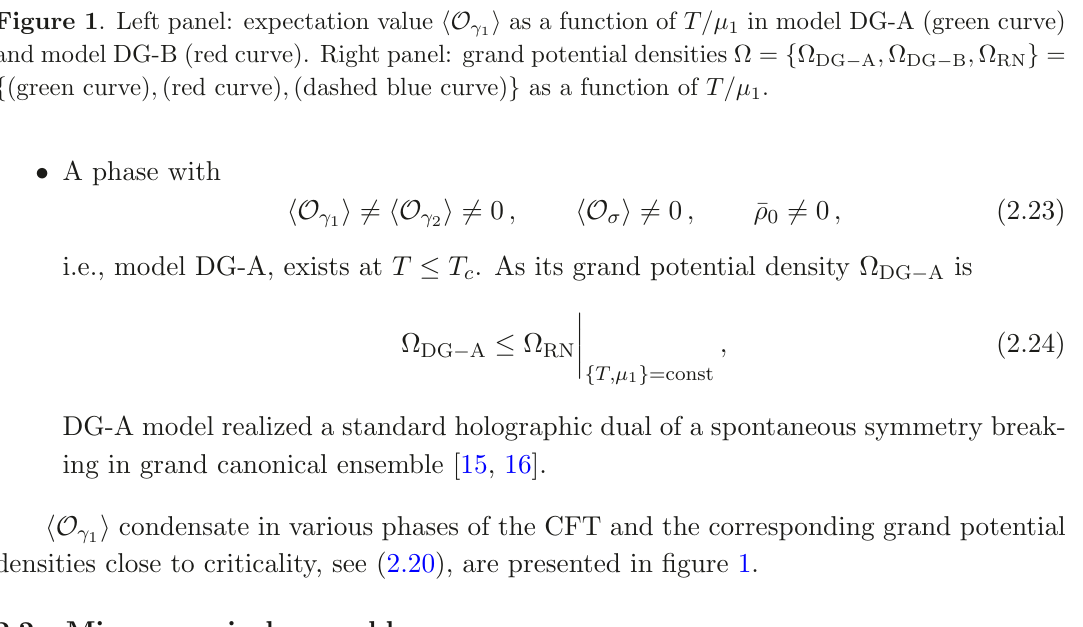
Ω DG − A , Ω DG − B , Ω RN = { }